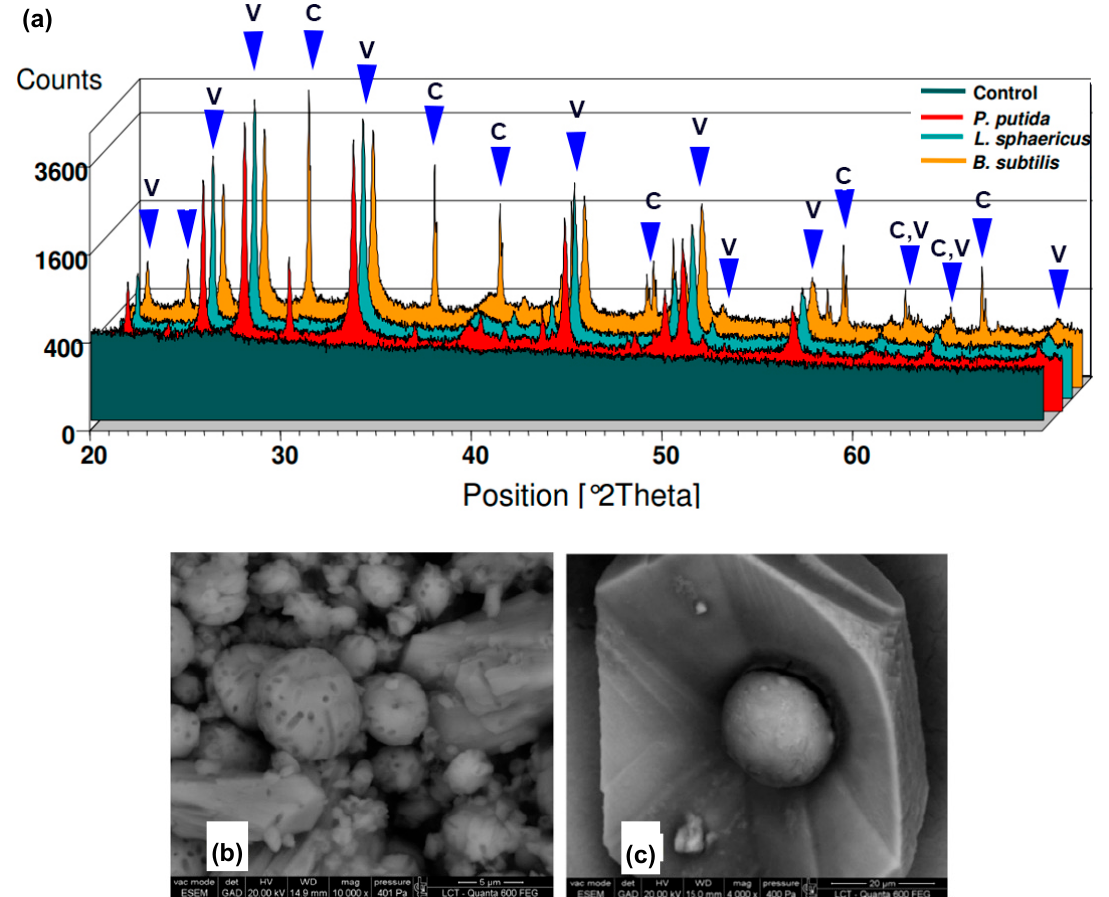
Figure 3. ( a ) The comparison of x-ray powder diffraction (XRD) patterns between control samples, P. putida, L. sphaericus, and B. subtilis . Environmental scanning electron microscopy (ESEM) images of ( b ) calcium carbonate crystals with bacterial presence evidence, and ( c ) spherical calcium carbonate within a rhombohedral and pinacoidal crystal. Adapted with permission from [7].